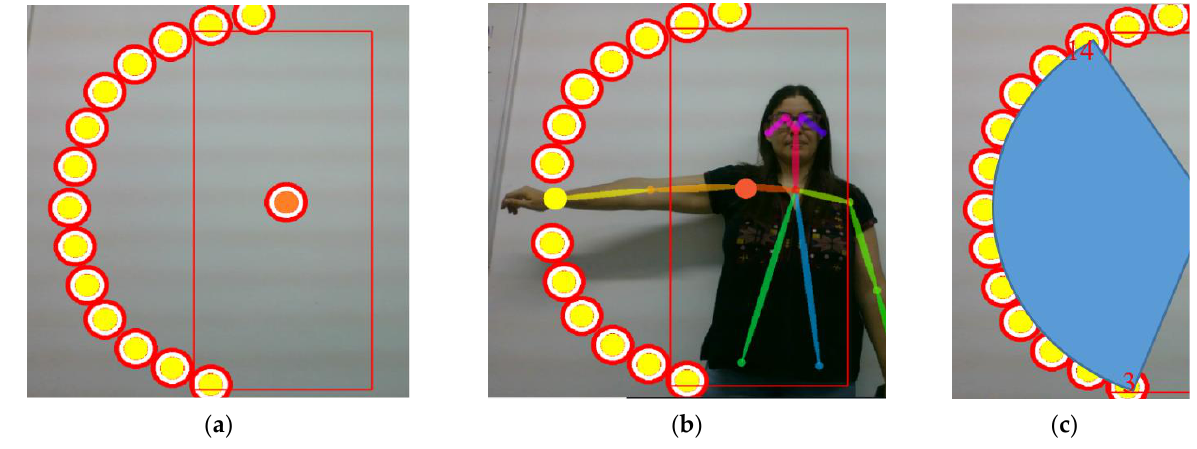
Figure 4. Example of shoulder abduction task. ( a ) Placement of the targets and elements to help the correct positioning of the patient. ( b ) Patient performing shoulder abduction. ( c ) Estimating ROM.